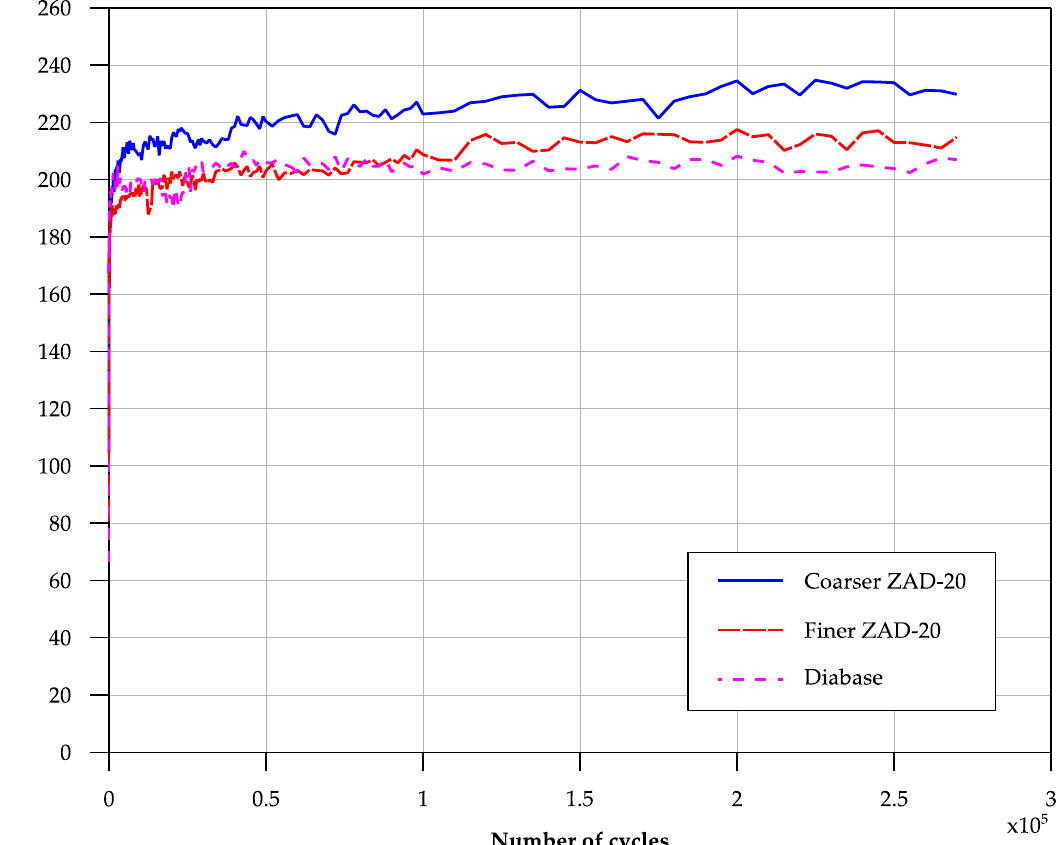
Figure 7. Evolution of the elastic modulus with the number of cycles.